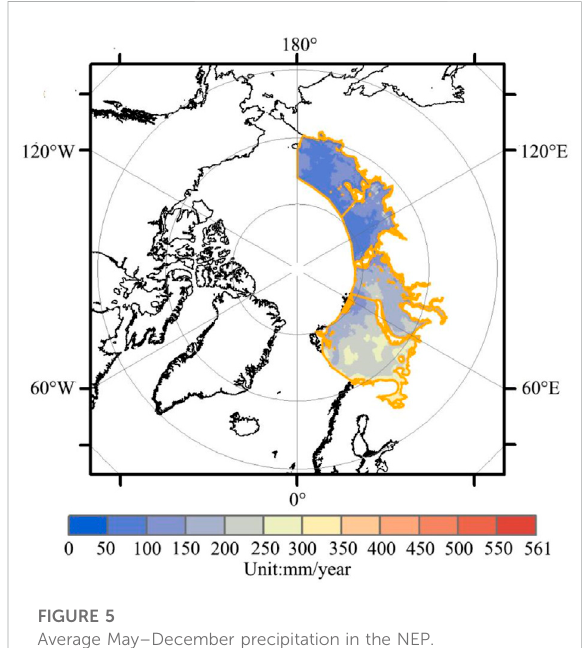
FIGURE 5 Average May – December precipitation in the